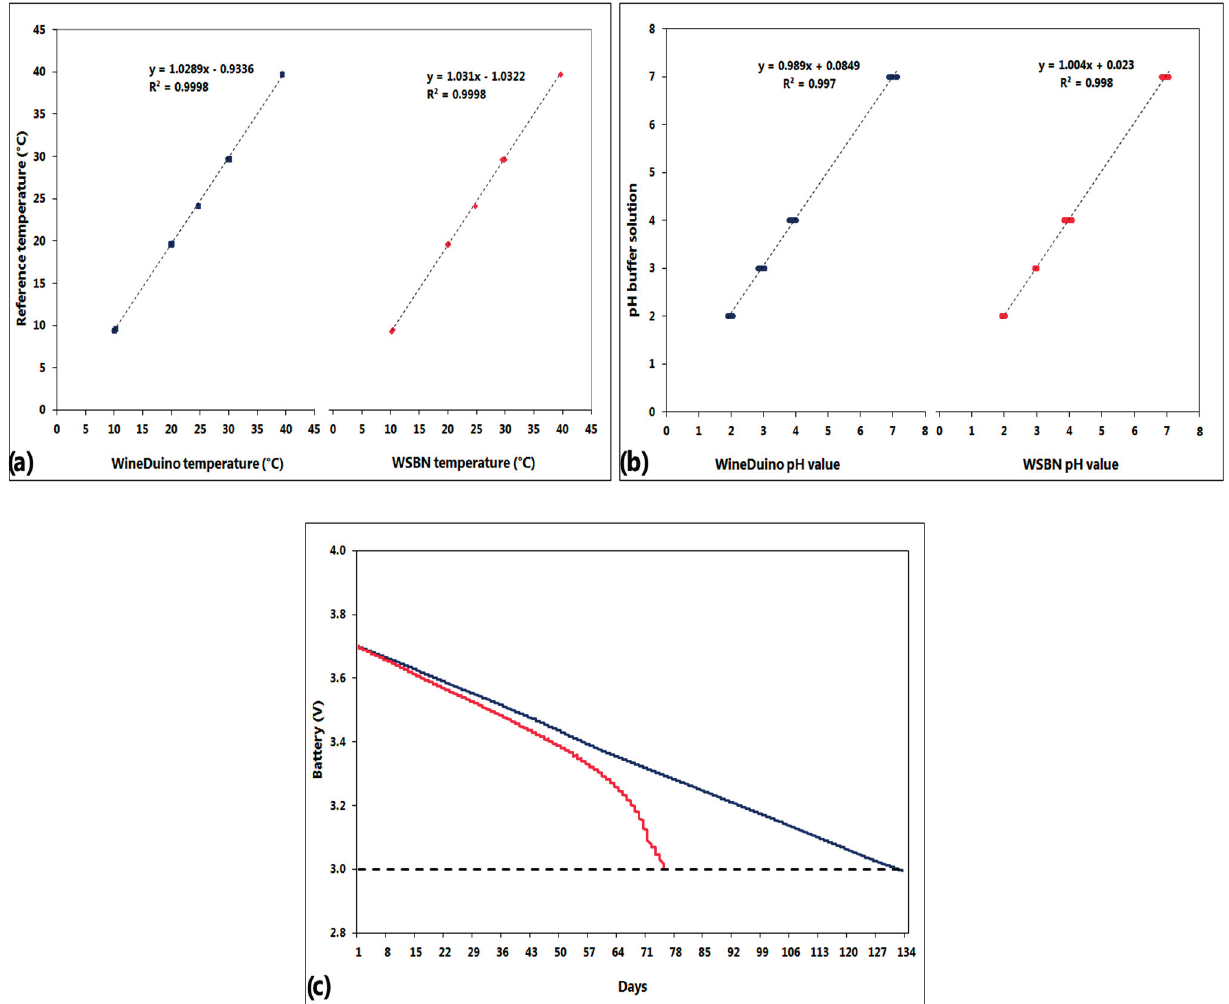
Figure 5. Performance comparison analysis between WineDuino system (blue) and WSBN (red) presented in the previous paper. ( a ) Temperature sensor calibration; ( b ) pH sensor calibration and ( c ) power supply